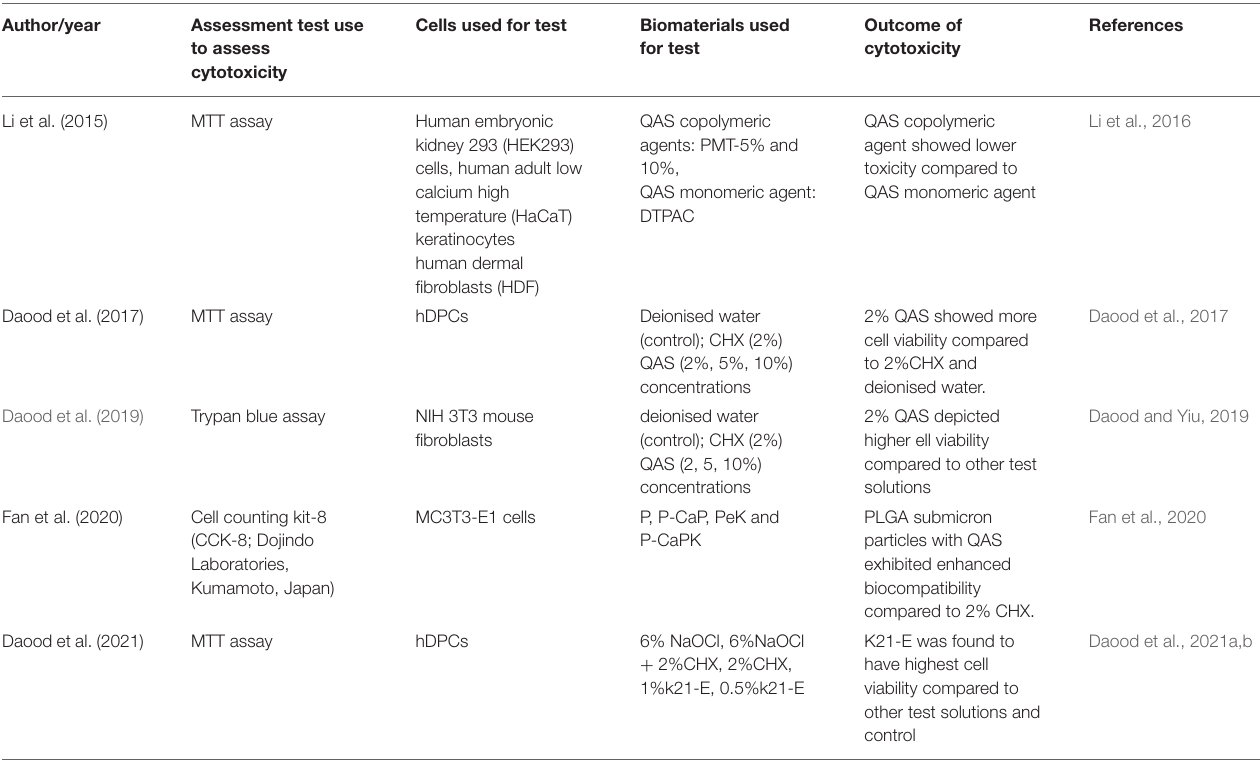
TABLE 2 | Research data on cytotoxicity of quaternary ammonium